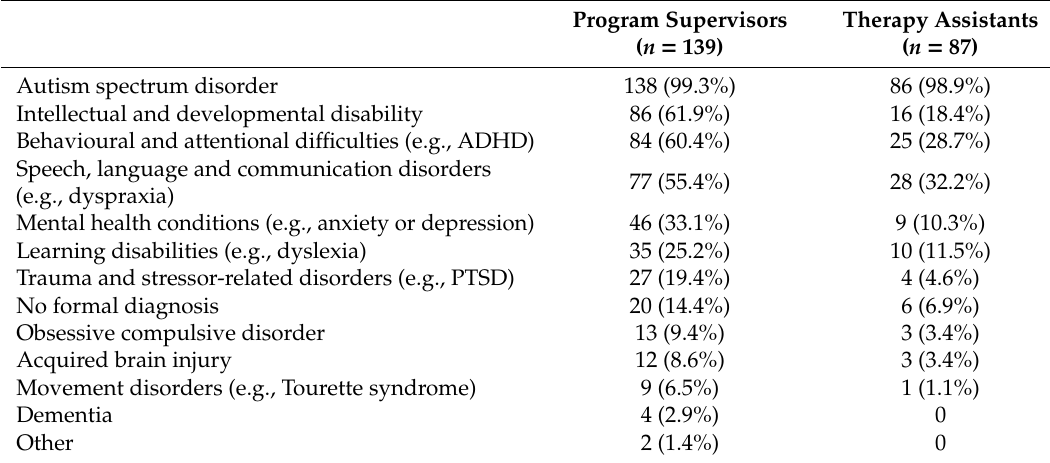
Table 2. Diagnoses of clients served by Australian program supervisors and therapy